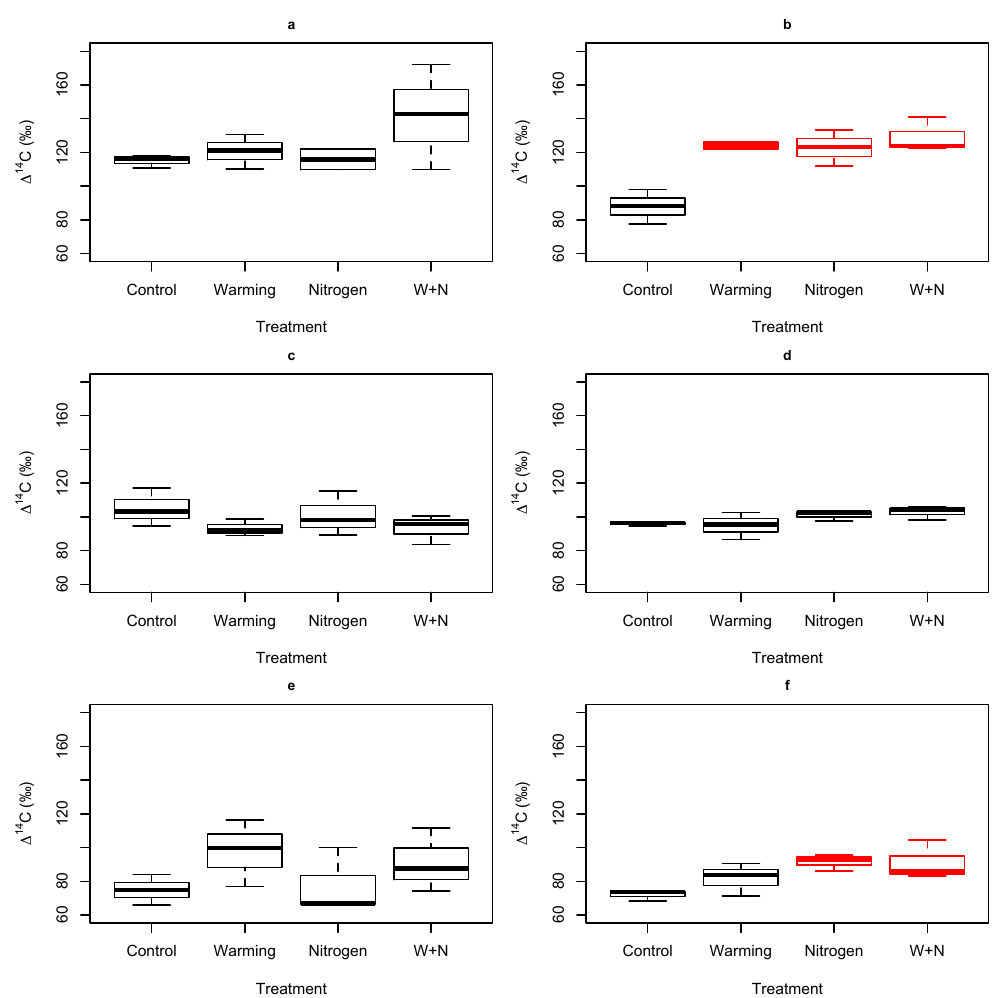
Fig. 5. Box plots of 1 14 C values in laboratory incubations measured in the organic (left-hand side panels) and mineral layers (right-hand side panels) two months (a, b) , two years (c, d) , and four years (e, f) after the start of the experiment. Differences in color represent statistical differences with the control treatment with α = 0 . 05 and Dunnett’s correction for multiple